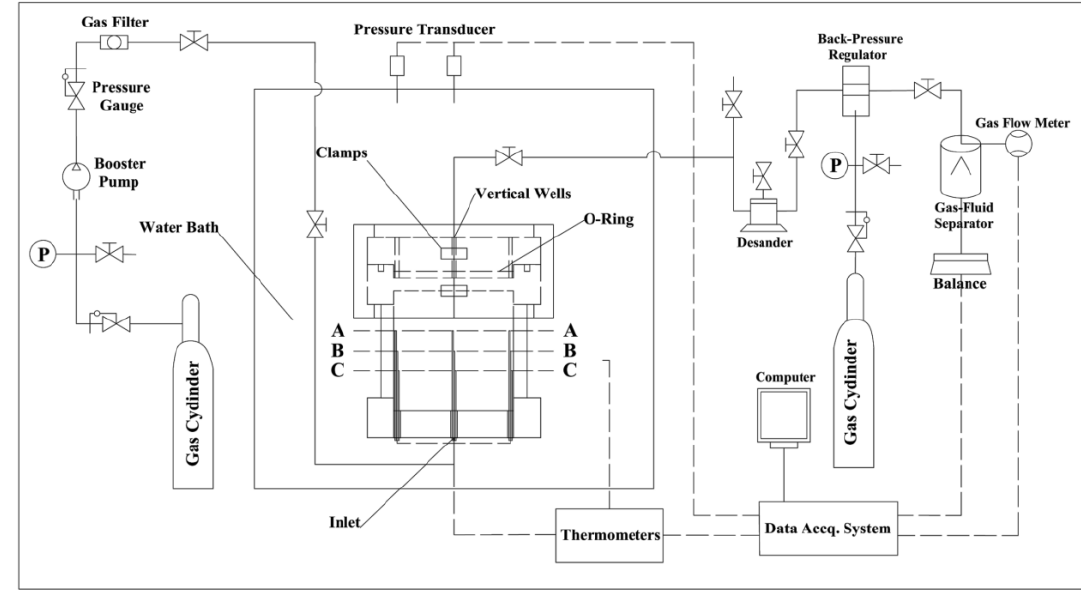
Figure 1. Experimental apparatus.